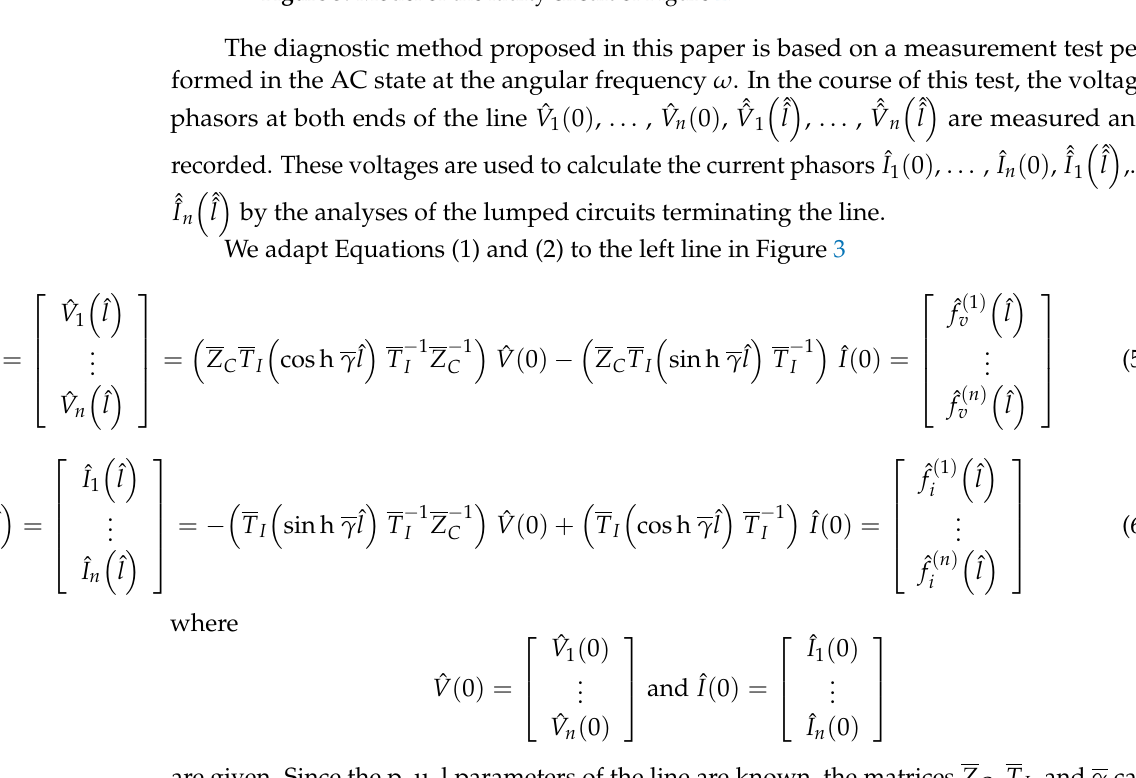
Figure 3. Model of the faulty circuit of Figure 2.